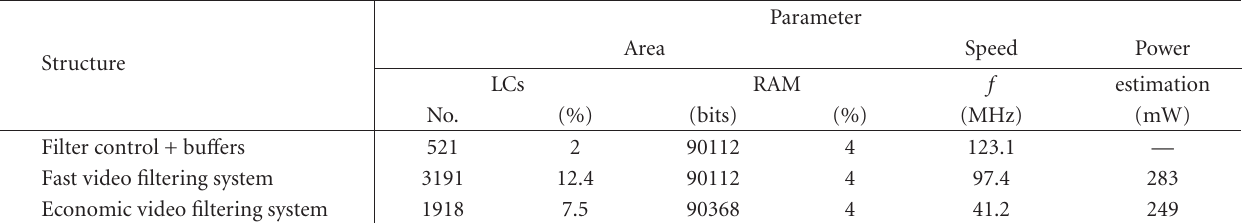
Table 8: Mapping of the complete video filtering system including control logic, line bu ff ers, and the proposed reduced NAVF scheme into